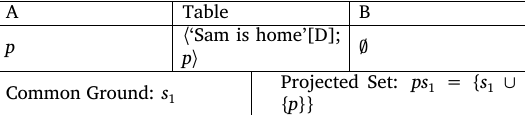
: A asserts “Sam is Table 1 K 1 home” relative to K 0